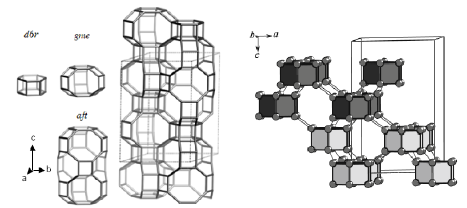
Figure 1. Left AFX framework type representa- tion using CBU and their arrangement (adapted from www.iza-online.org), right - AFX framework type rep- resentation using 6-6 SBU (adapted from Ilyushin et al. 2015).